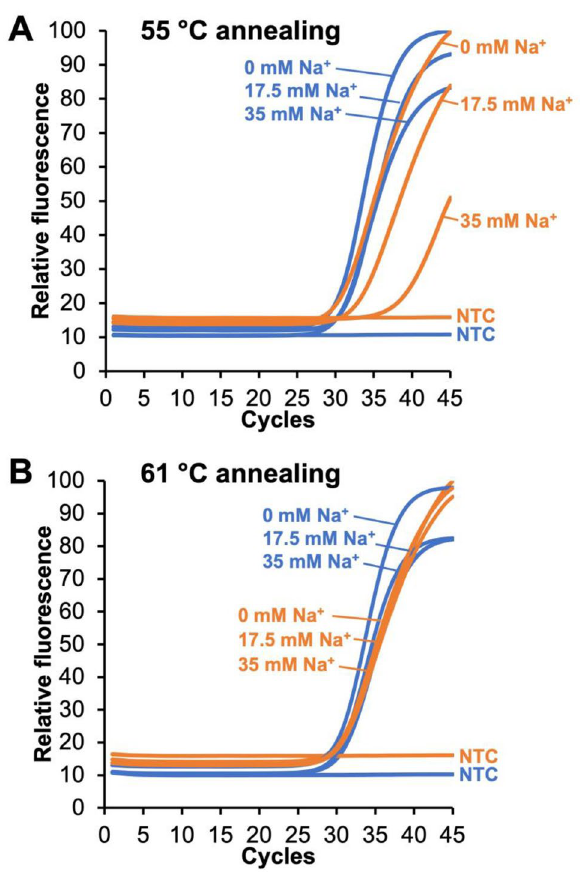
Figure 3. Effect of sodium concentration and annealing temperature on the qRT-PCR performance of N1 and N2 reactions. ( A ) At an annealing temperature of 55 °C, increasing sodium has no effect on N1 performance (blue curves) but a major impact on N2 performance (orange curves). ( B ) At an annealing temperature of 61 °C, however, increasing sodium has no effect on N1 (blue curves) or N2 performance (orange curves). Each curve is the average of four experiments (N =